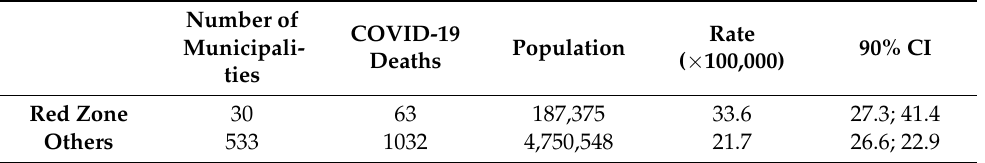
Table 1. COVID-19 mortality estimated rates and 90% confidence intervals (CI) for the Red Zone and the other municipalities between 15 February and 15 April 2020, Veneto Region.